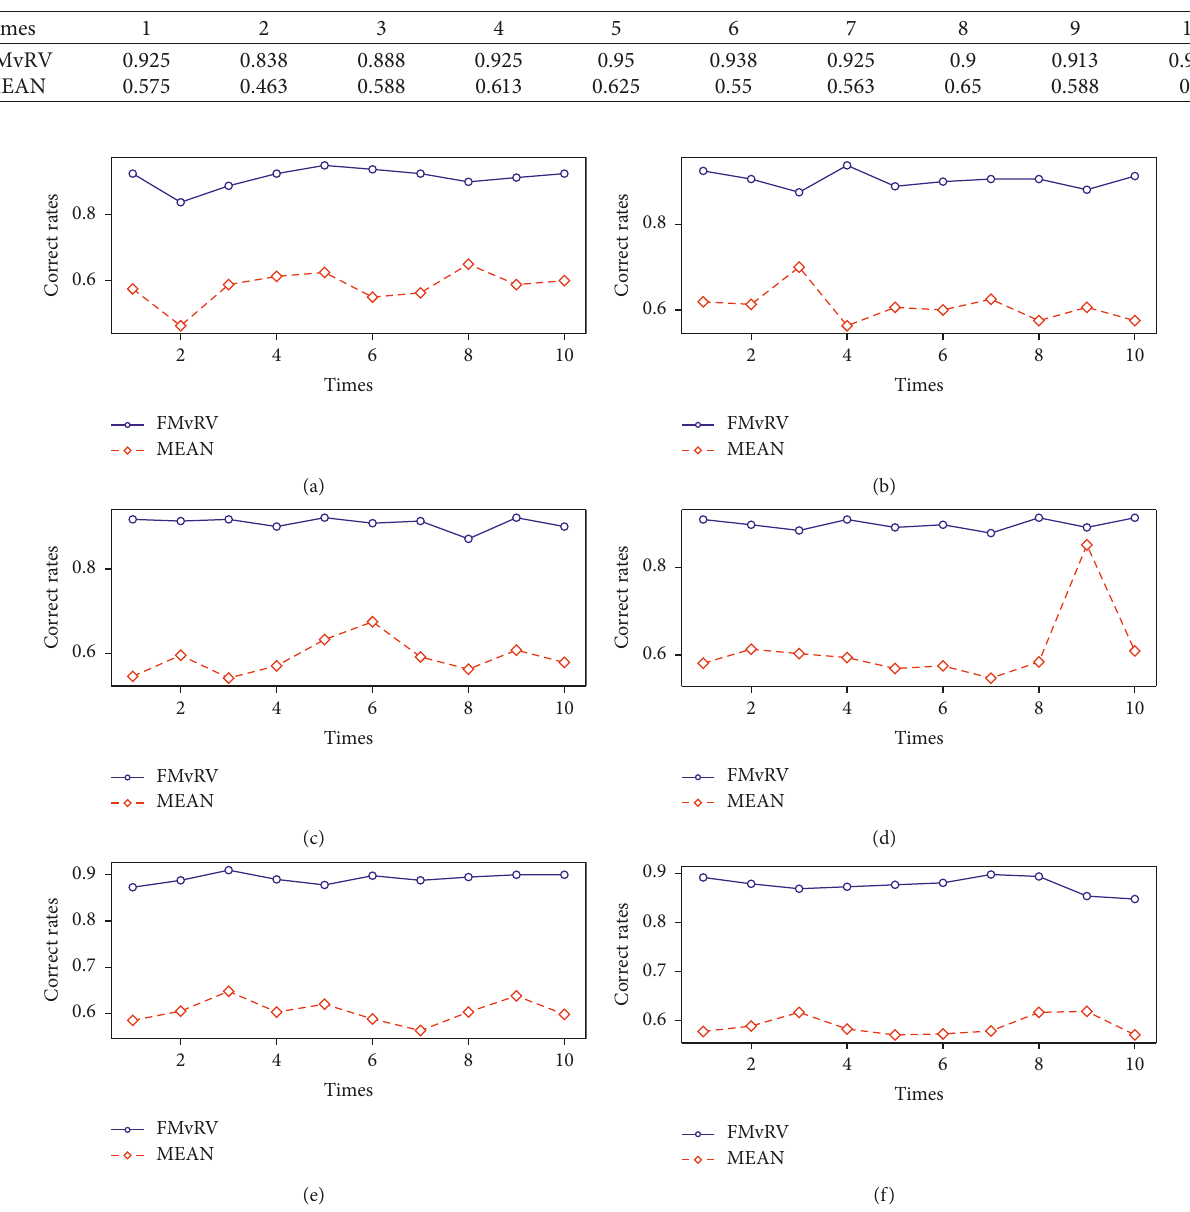
Figure 5: Comparison of the correct rates of Algorithms FMvRV and MEAN in terms of AB200 with 5% − 30% missing values. (a) 5% missing values. (b) 10% missing values. (c) 15% missing values. (d) 20% missing values. (e) 25% missing values. (f) 30% missing values.